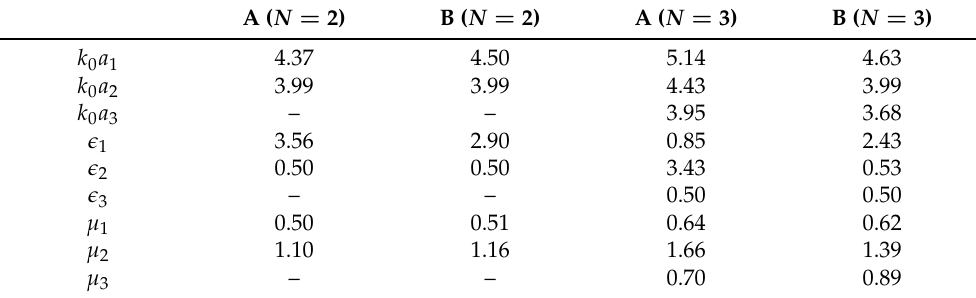
Table A4. Values of the optimization variables for optimized designs A and B of Figure